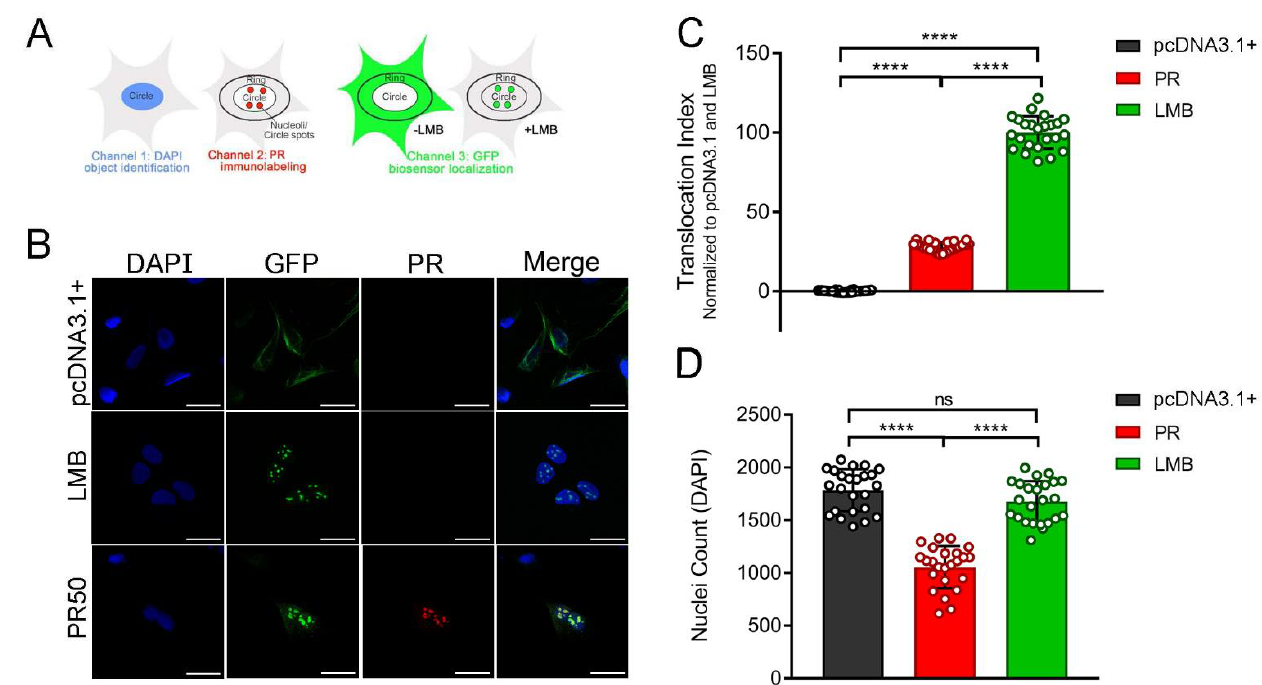
Figure 2. PR 50 alters the cellular localization of the NCT-C biosensor. ( A ) Schematic of the NCT-C biosensor and automated image segmentation strategy. U-2 OS cells expressing the biosensor composed of GFP fused with the Rev-NLS and cNES (green). Nuclei were stained by exposure to DAPI (blue). Image acquisition corresponding to the emission wavelengths (channels) of DAPI, immunolabeled PR (red), and GFP was performed using a Cellomics Arrayscan VTI scanner. Image segmentation was carried out using the HCS Studio software that identifies differences in signal intensity for each channel. Pixels corresponding to cellular nuclei (circles) were assigned by high DAPI signal intensity while the surrounding image area was designated as cytoplasm (ring). ( B ) Confocal images of U-2 OS cells expressing the NCT-C biosensor (green) transfected with empty vector control (pcDNA3.1+), 2 h LMB treatment (2 ng/mL), or 24 h PR 50 overexpression conditions. Scale bar = 40 µm. ( C ) Quantification of the NCT-C biosensor translocation index (circle average GFP intensity–ring average GFP intensity), normalized to pcDNA3.1+ (0%) and LMB (100%) in U-2 OS cells. Each data point represents a technical replicate. One-way ANOVA; F (2, 69) = 1683; **** p < 0.0001. ( D ) Quantification of cell counts in U-2 OS cells transfected with empty vector, treated with LMB (2 h at 2 ng/mL), or 24 h PR 50 overexpression conditions. One-way ANOVA; F (2, 69) = 94.01; **** p < 0.0001; ns = non-significant.